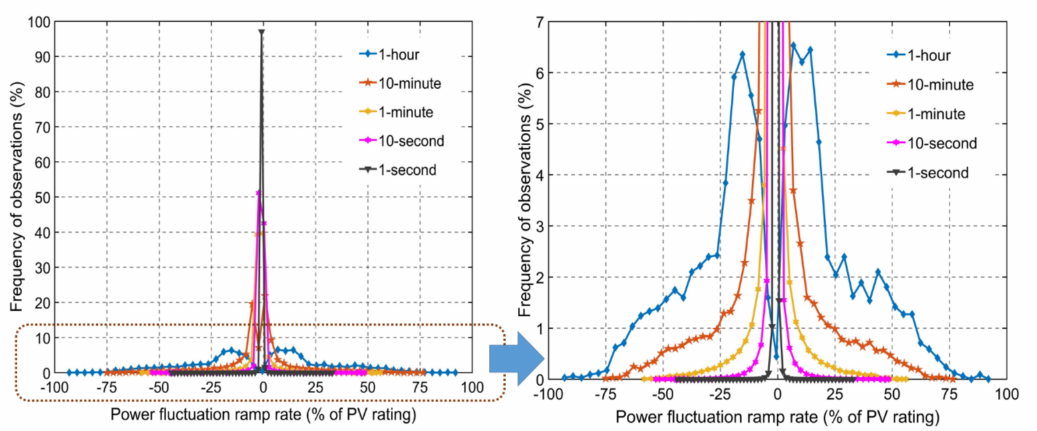
Figure 10. Extracted power ramp rates from the PV generation measurement dataset in Tsukuba, Japan.